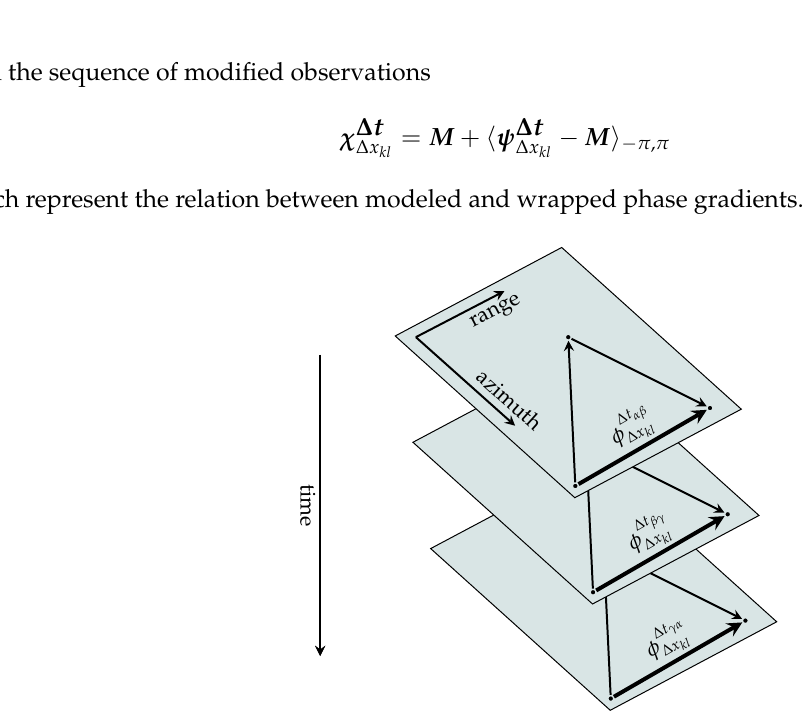
Figure 4. Temporal relationship for one spatial arc. The thickly marked line is analysed in time. To